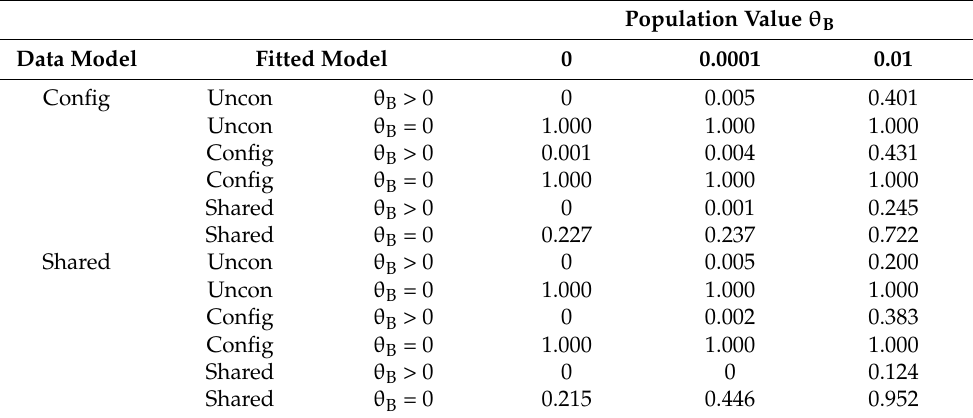
Table A1. Convergence rates with 100 clusters for ML estimation with QN in M plus with population θ B being zero, 0.0001, and